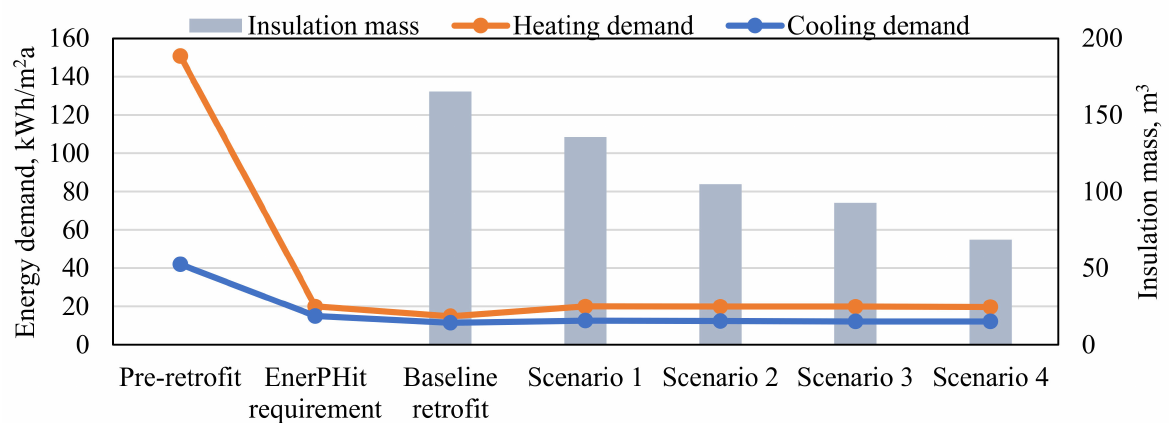
Figure 9. Comparing the energy demand between the pre-retrofit, baseline retrofit and improved retrofit plans against the EnerPHit standard